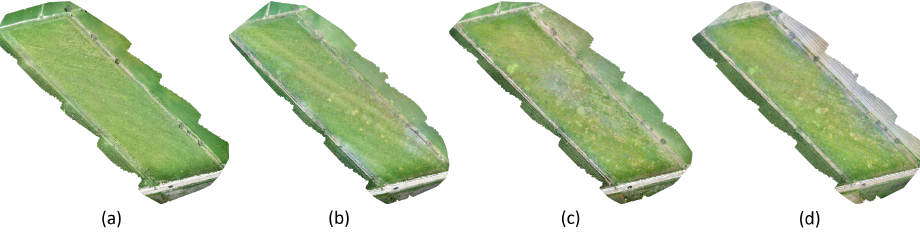
Figure 3. Orthomosaics from test missions: ( a ) 14 July 2021, ( b ) 8 August 2021, ( c ) 29 August 2021, and ( d ) 11 September